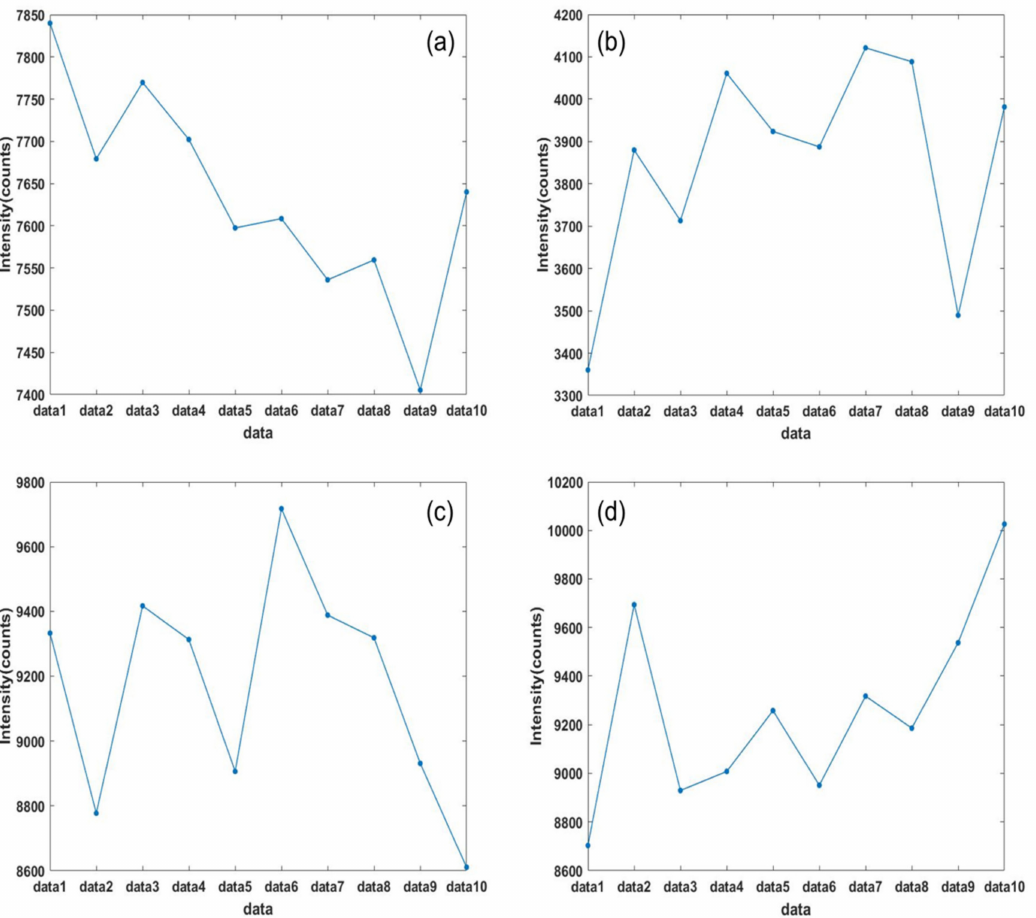
Figure 2. ( a ) Point data of the same wavelength of 10 sets of sunlight spectrum data collected every 10 s. ( b ) Point data of the same wavelength of 10 sets of screen green light spectrum data collected every 10 s. ( c ) Point data of the same wavelength of 10 sets of screen blue light spectrum data collected every 10 s. ( d ) Point data of the same wavelength of 10 sets of screen red light spectrum data collected every 10